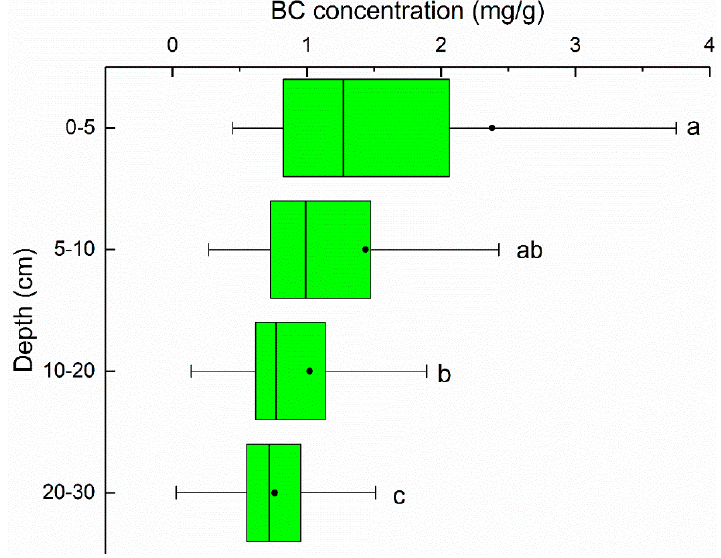
Figure 3. Vertical distribution of BC in soils on burned areas in the Great Khingan Mountains. The black points in the box plots were mean values of BC.